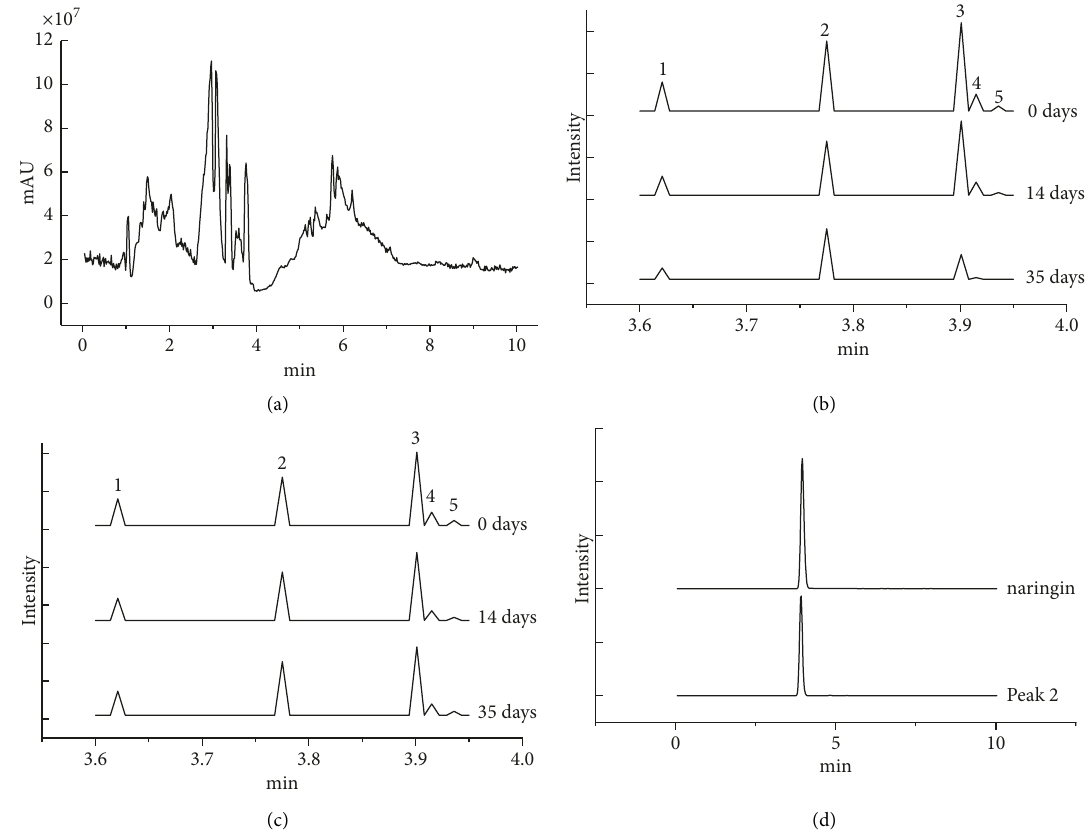
Figure 1: (a) Chromatogram of vegetables and fruits solutions. (b) Chromatograms of five bioactive candidates from vegetables and fruits solutions. Peaks 1, 2, 3, 4, and 5 represent the five bioactive ingredients. All the peak areas decrease gradually from 0 days to 14 days to 35 days during storage. The differences were statistically significant. (c) Chromatograms of five bioactive candidates in blank control without RBCs. Peaks 1, 2, 3, 4, and 5 represent the five bioactive ingredients. All the peak areas have no changes from 0 days to 14 days to 35 days during storage. (d) Chromatograms of naringin and bioactive components of peak 2. Table 2: MS data of five bioactive candidates of vegetables and fruits. Peak